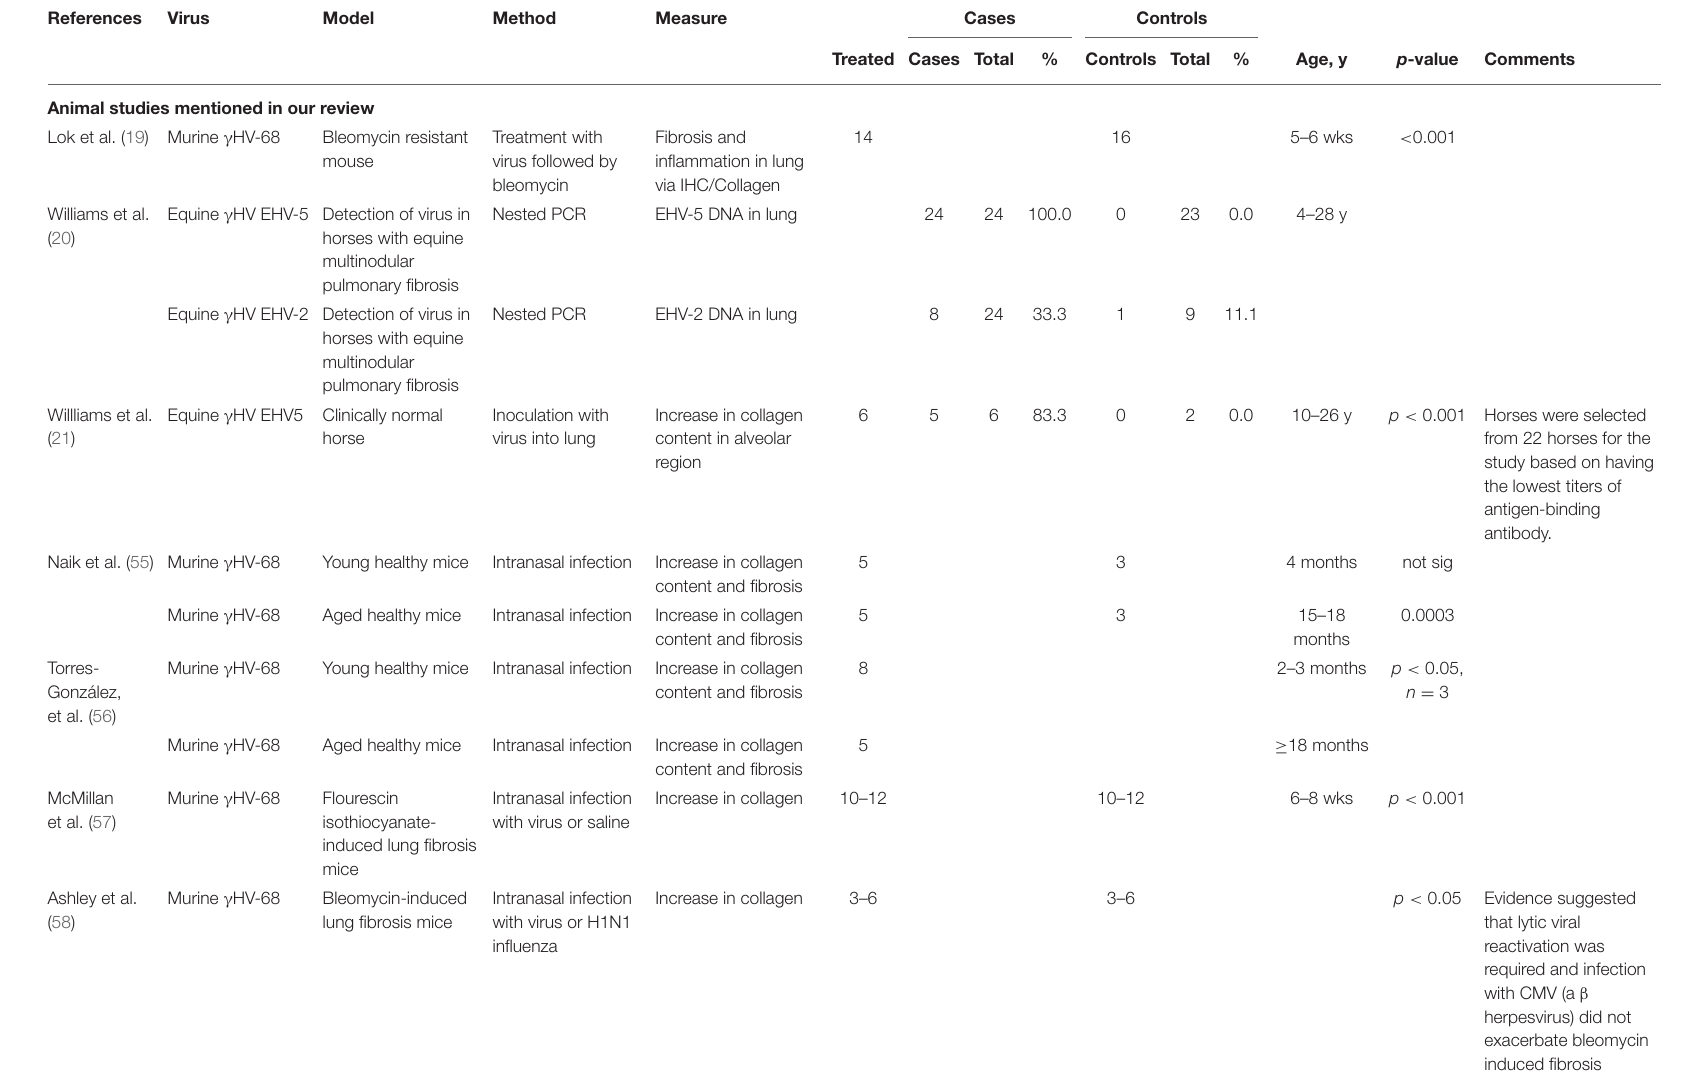
TABLE 2 | Studies of potential role of herpes viruses in pulmonary fibrosis: animal